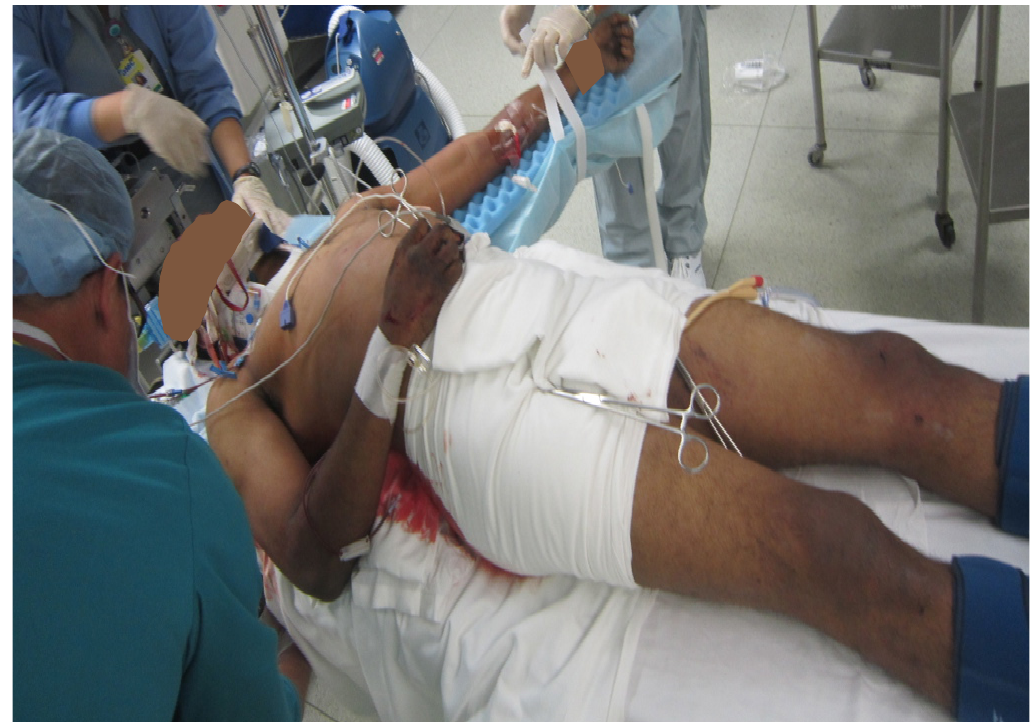
Figure 1. Use of a noninvasive pelvic circumferential compression device (PCCD) has become commonplace, and has become a well- established component of ATLS